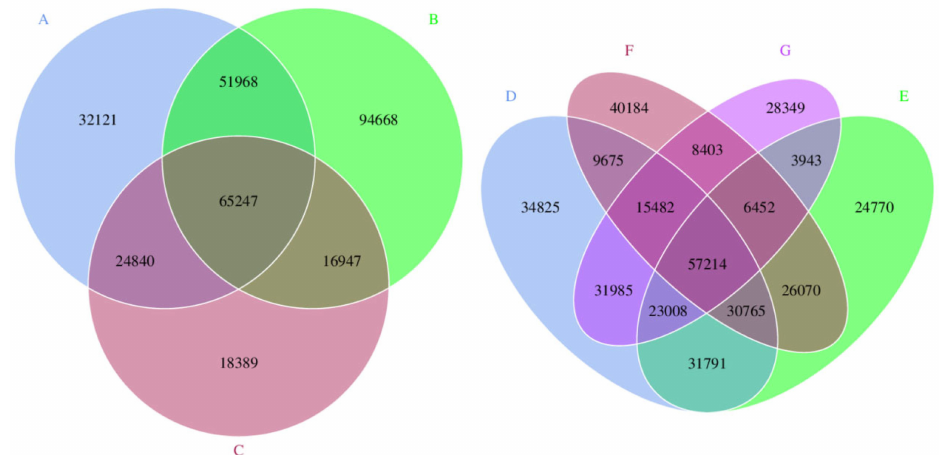
Figure 4. Number of genes. In the figure, each circle represents a sample; the numbers in the overlapping parts of the circles represent the number of genes shared between the samples; the numbers without the overlapping part represent the unique number of genes of the sample.